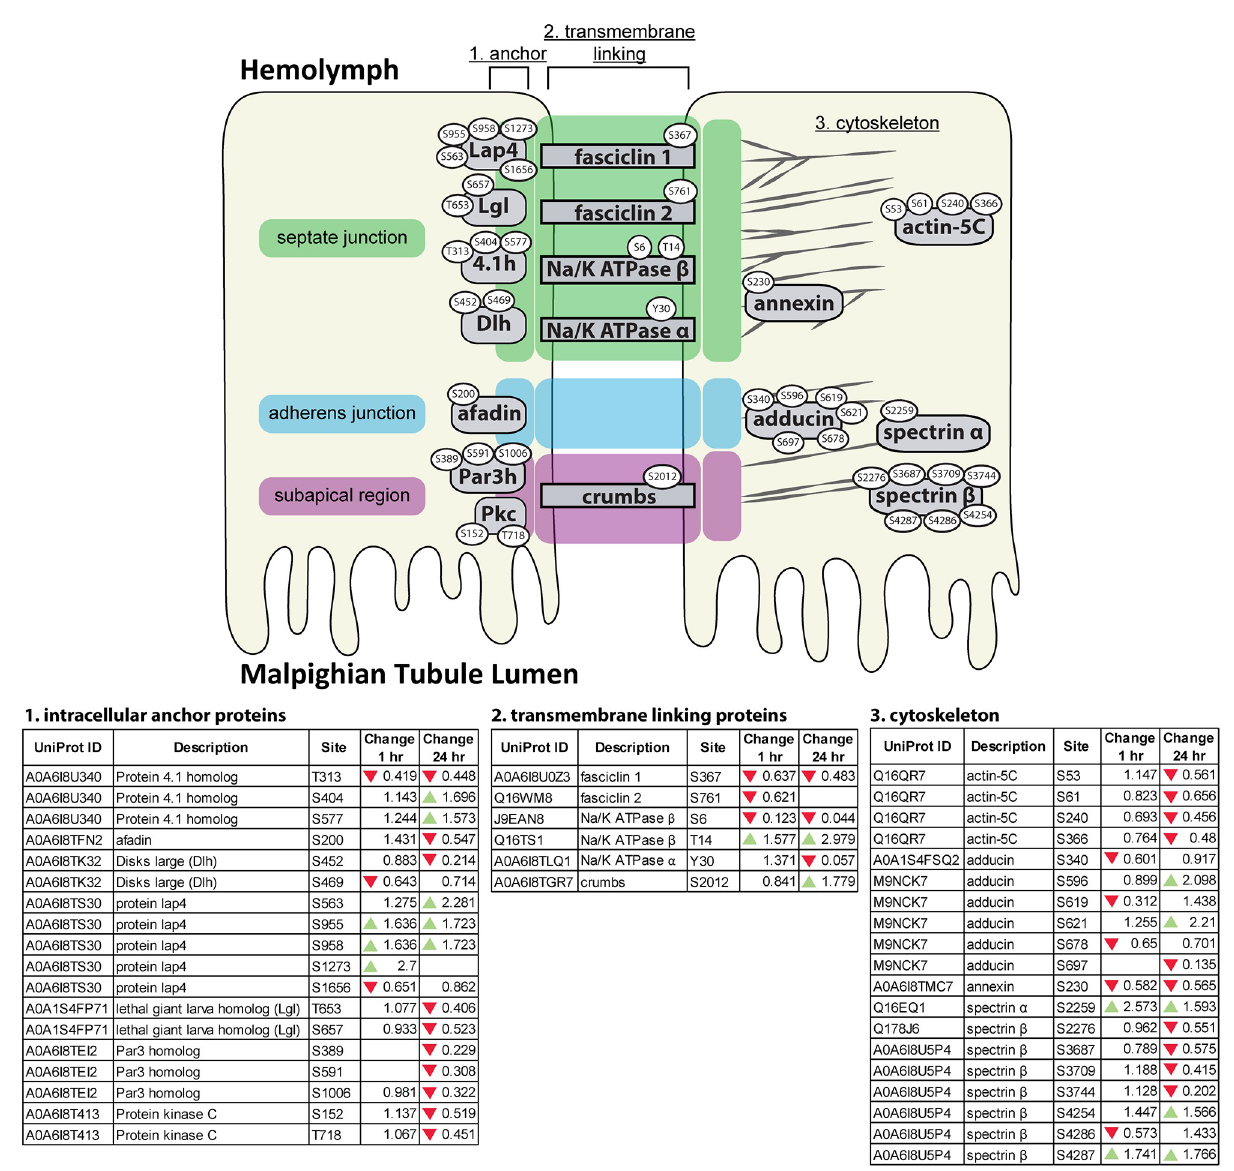
Fig 6. Changes in phosphorylation of cell-cell adhesion proteins. Ae . aegypti proteins associated with cell junctions conserved in other eukaryotic organisms are illustrated (reviewed in Beyenbach & Piermarini, 2011 ). Specific amino acid residues on proteins with phosphorylation changes of at least 1.5-fold between unfed and blood-fed mosquitoes are shown in white ovals. Proteins in green highlighted regions are associated with septate junctions. Proteins in blue highlighted regions are associated with adherens junctions. Proteins in purple regions are associated with subapical region junctions. Numbers in the figure correspond to tables where proteins with related functions are grouped. Tables contain the Uniprot IDs for each protein as well as the fold-change in phosphorylation of each residue between unfed and either 1hr PBM or 24hr PBM mosquitoes. Green arrows represent an increase of at least 1.5-fold in phosphorylation at the specified residue between unfed and PBM mosquitoes, and red arrows represent a decrease of at least 1.5-fold in phosphorylation at the specified residue between unfed and PBM mosquitoes.